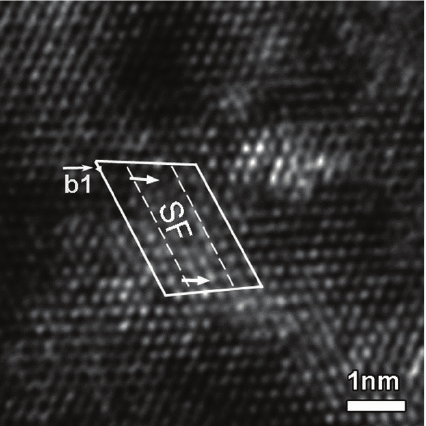
Figure 7: High resolution electron photomicrograph with extended dislocation in 𝛼